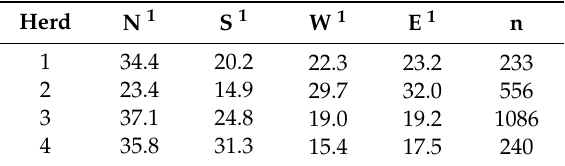
Table 1. Orientation of the body axis of cows lying on pasture from four herds on a farm with 205 cows in Uruguay; north, east, south, or west orientation per herd. Results from 2115 live observations. Herd N 1 S